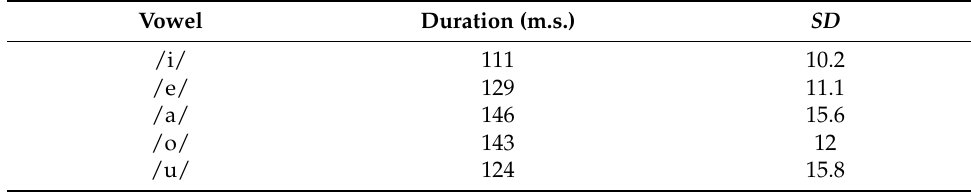
Figure 1. F1 × F2 of CG and RP vowels. Table 1. Duration of CG vowels.